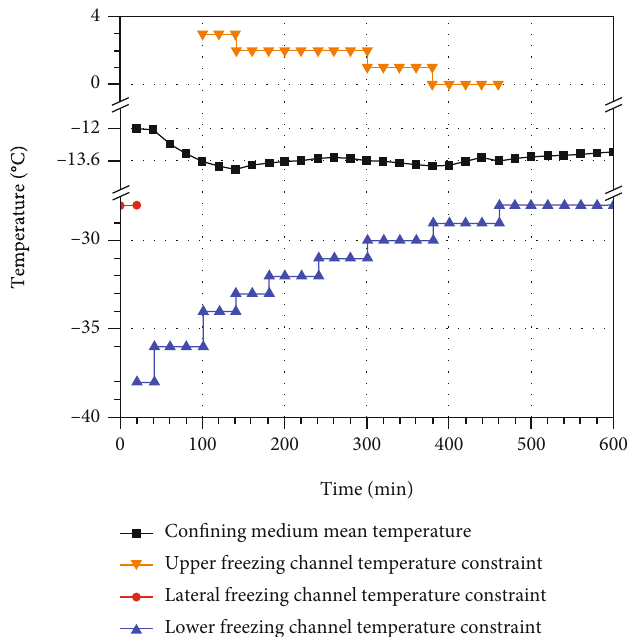
Figure 11: Changes in the adjusted temperature constraints on the three freezing channels and the simulated mean temperature of the con fi ning medium under the conditions that the initial oil temperature is -12 ° C and the freezing pressure is 20 MPa.